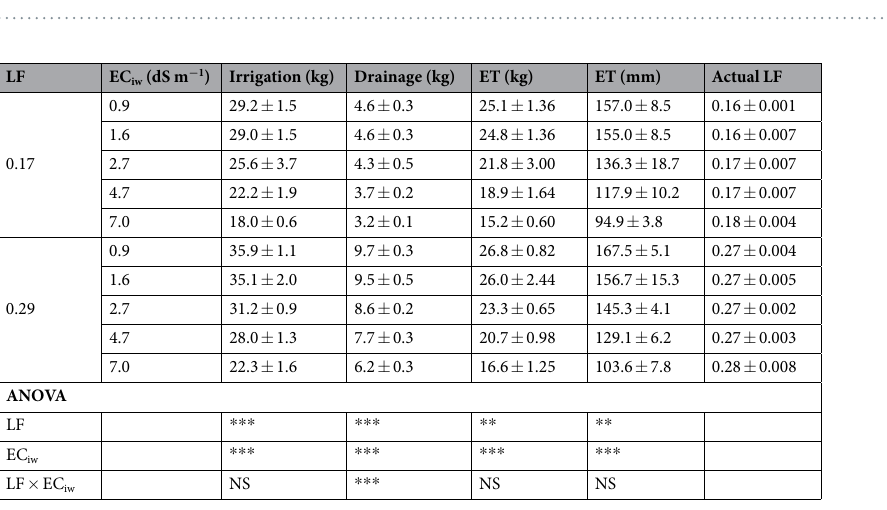
Table 3. Effects of irrigation water salinity (EC iw ) and leaching fraction (LF) on seasonal irrigation, amount of drainage water, evapotranspiration (ET) and actual LF using two–way analysis of variance (ANOVA) ** and *** represent significant differences between means at 0.01 and 0.001 level of probability, respectively; NS, non– significant. Each value is mean ± S.D. (n =